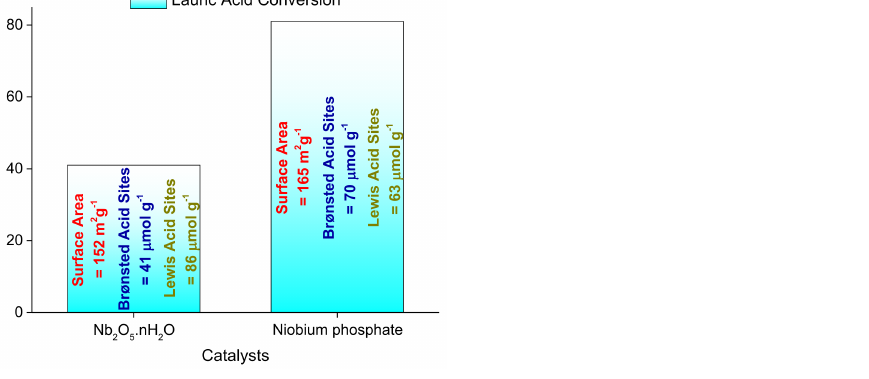
Figure 15. Lauric acid esterification with butyl alcohol over Niobium oxide or Niobium phosphate. Reaction conditions: butanol: lauric acid molar ratio (10:1), catalyst (10 wt% in relation to the lauric acid), temperature (120 ◦ C), time (4 h) (adapted from [9]).